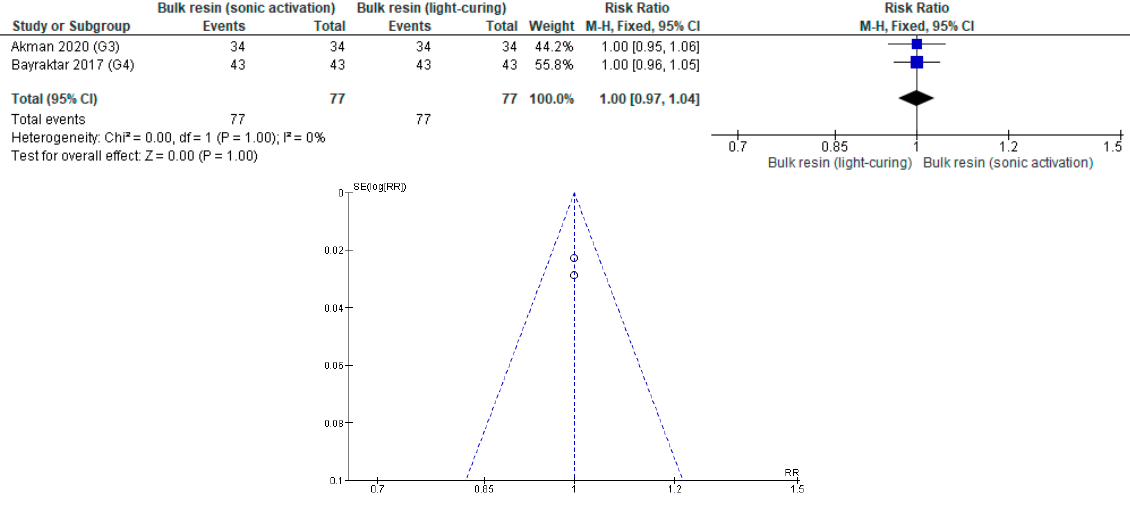
Figure A5. Absence of Fractures: Bulk Resin (with Sonic Activation) versus Bulk Resin (Two-Step Technique).